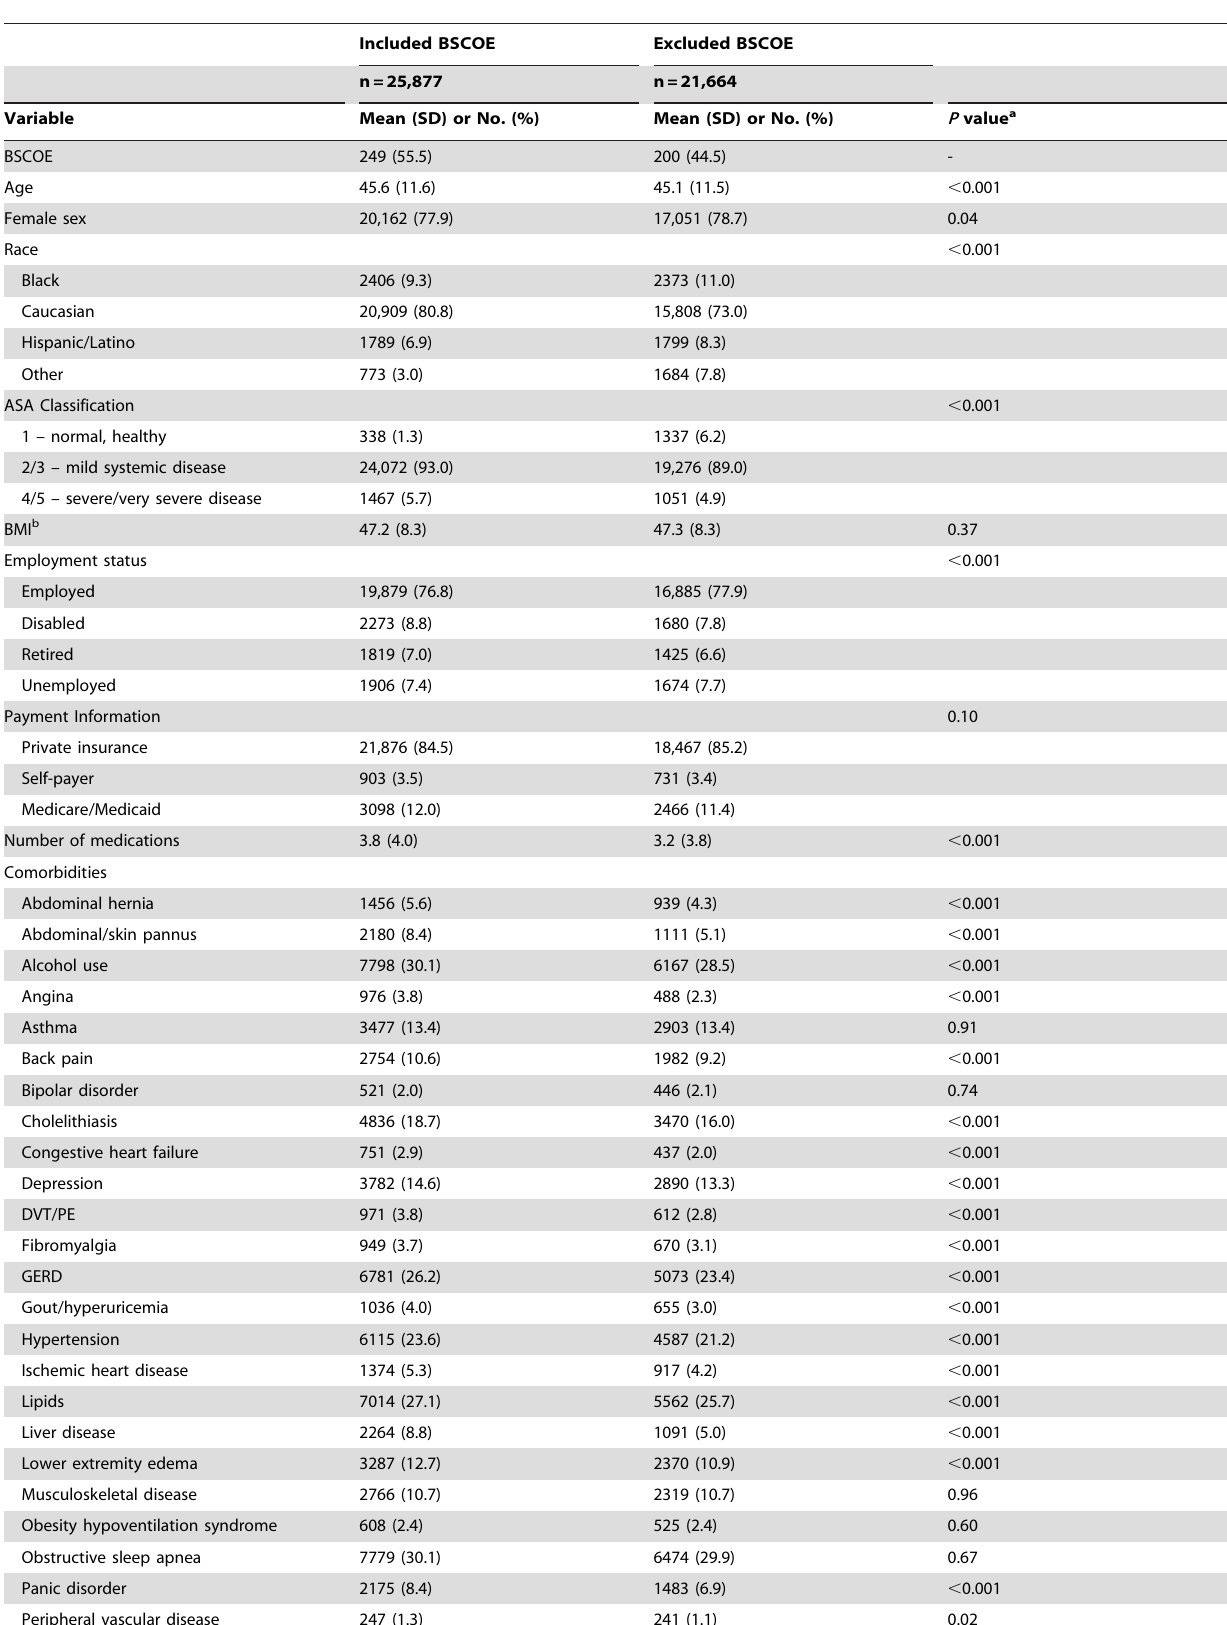
Table 5. Comparison of RYGB Patients from Included and Excluded BSCOE.